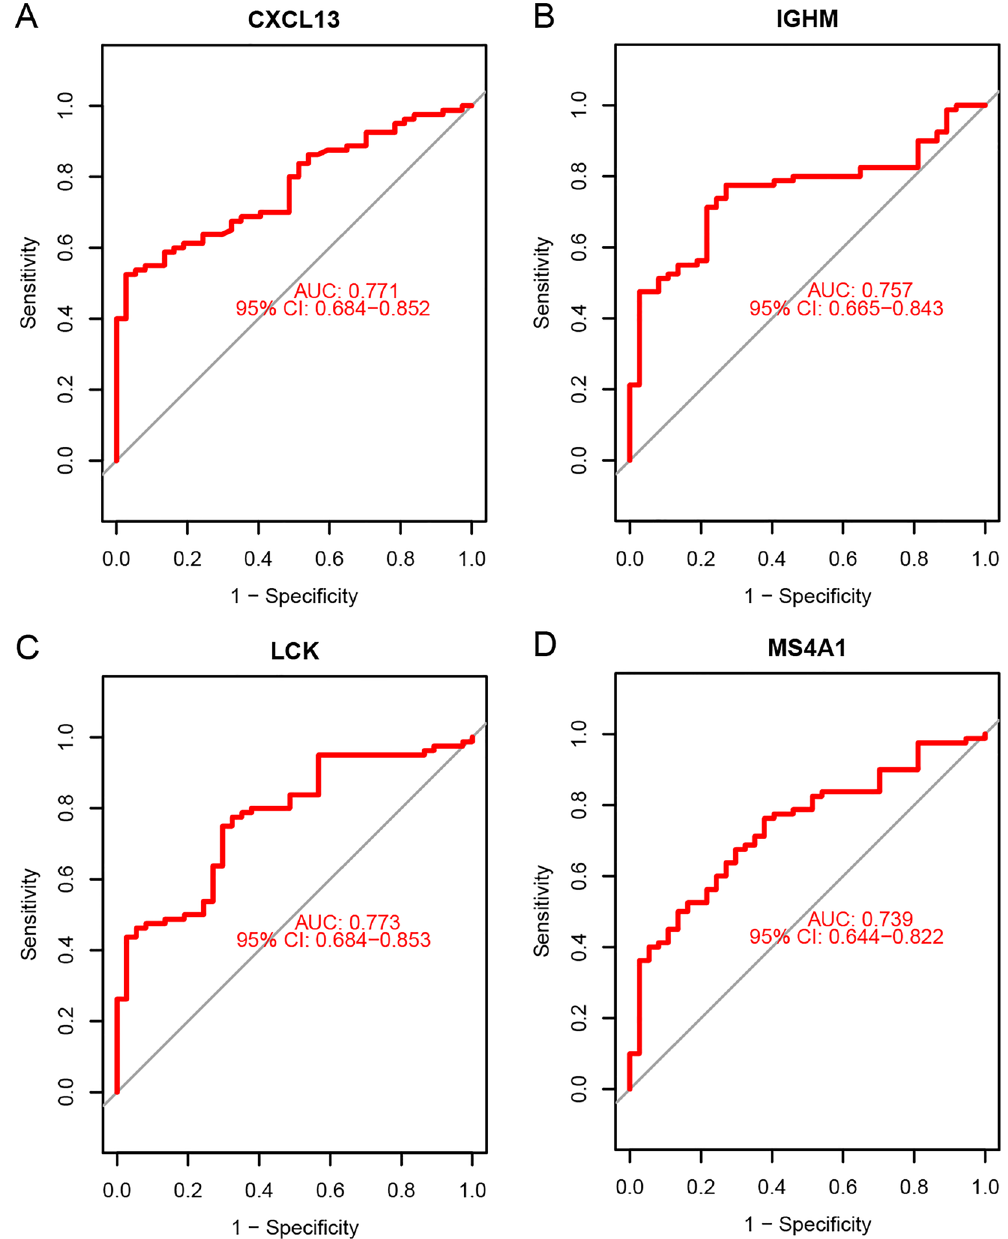
Figure 4. ROC curve analysis in the training cohort. ( A ) ROC curves of the expression of CXCL13 to predict RA. ( B ) ROC curves of the expression of IGHM to predict RA. ( C ) ROC curves of the expression of LCK to predict RA. ( D ) ROC curves of the expression of MS4A1 to predict